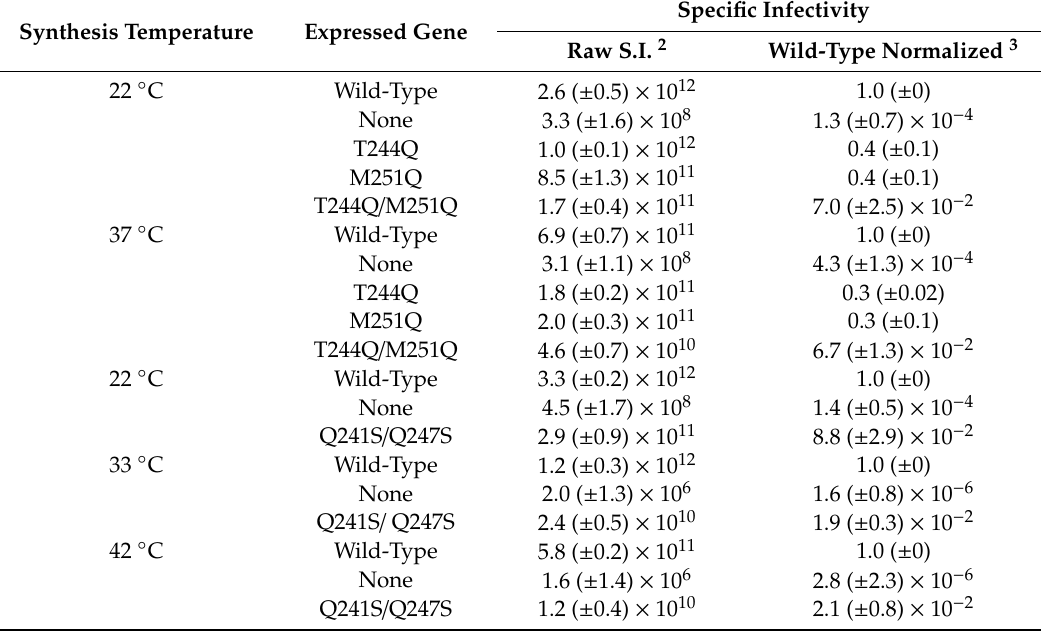
Table 3. Specific infectivity 1 of 114S particles at 37 ◦